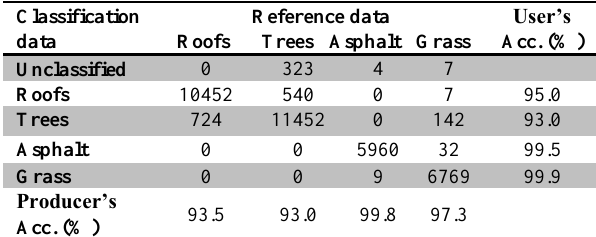
Table 4. Confusion matrix based on NDVI C2-C1 Classification